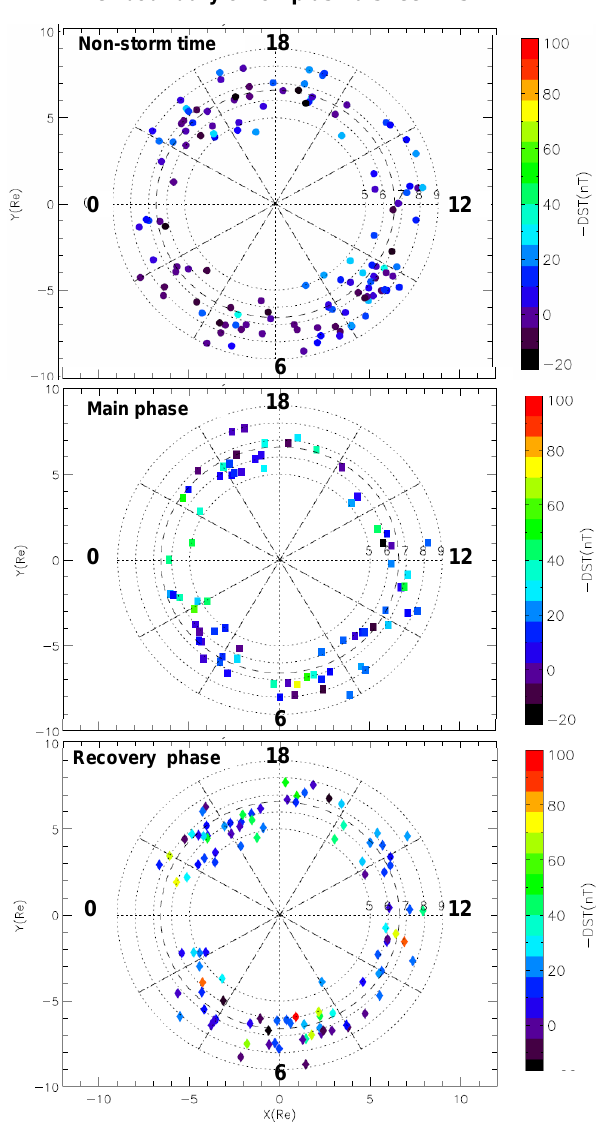
Fig. 6. The scatter plot of inner boundary of ion plasma sheet de- tected by TC-1 in the X-Y GSM plane color-coded according to Dst